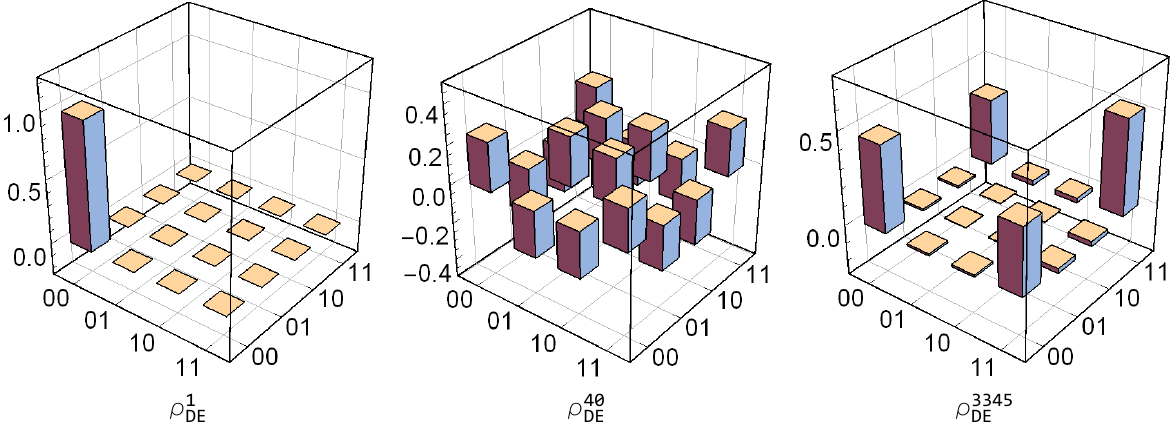
Figure 3. Bar plots of density matrices ρ 1 ment is obtained between D and E throughout